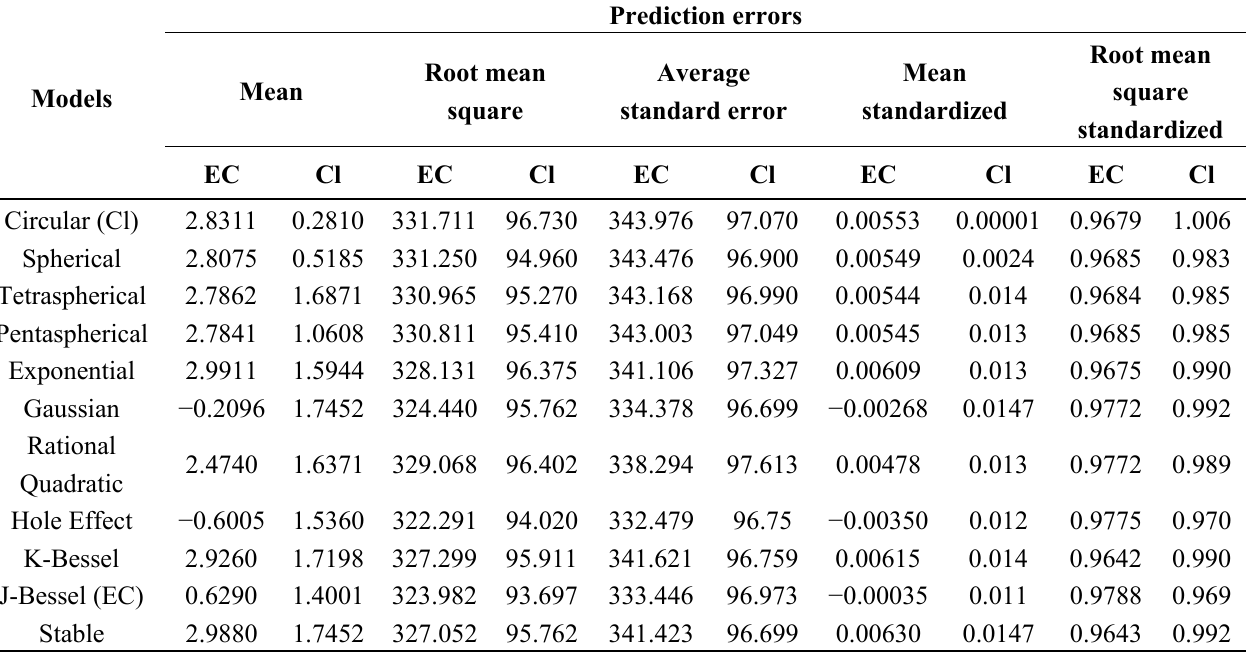
Table 8. Cross validation results of EC and Cl parameters.